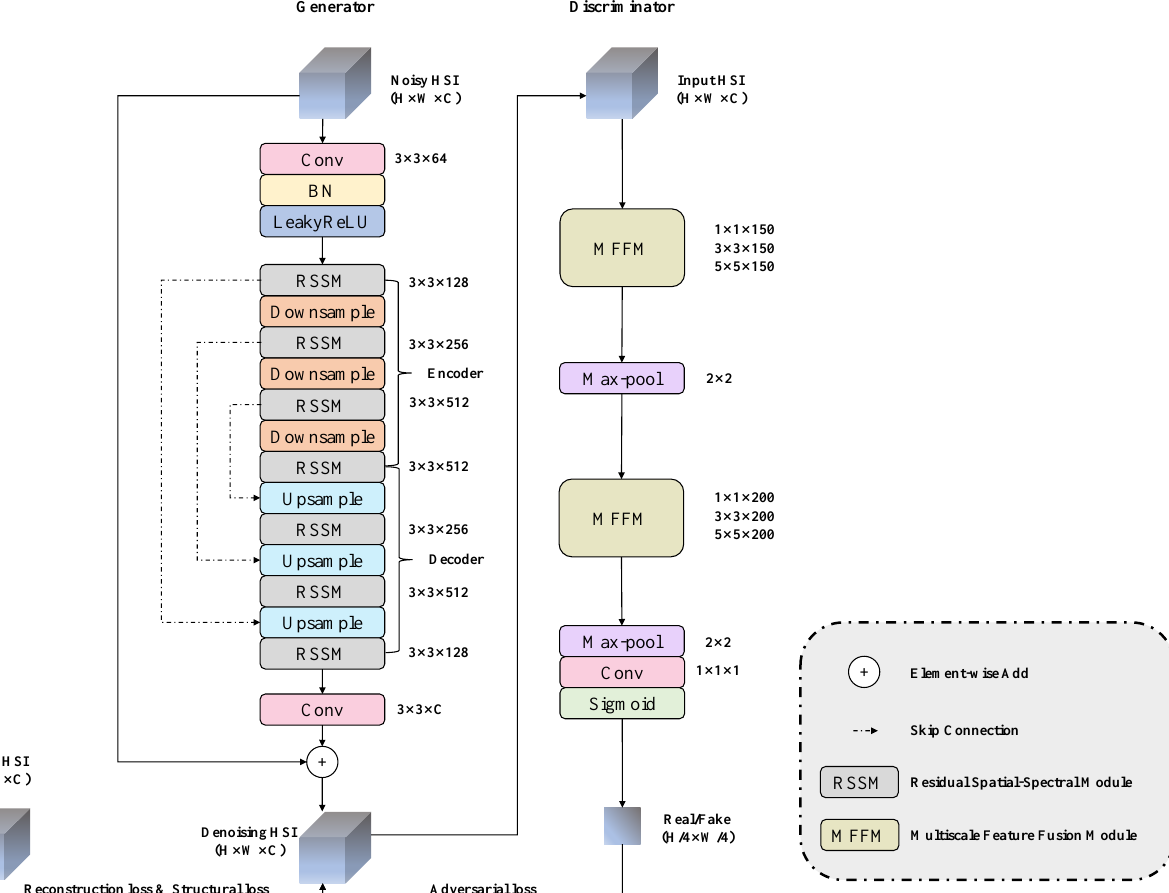
Figure 1. The proposed network architecture including the generator and the discriminator. The noisy HSIs are fed to the generator, and the denoising HSIs are then generated and fed to the discriminator. The discriminator learns to distinguish whether the input HSIs are from the generator or ground truth. The generator intends to generate more realistic HSIs to deceive the